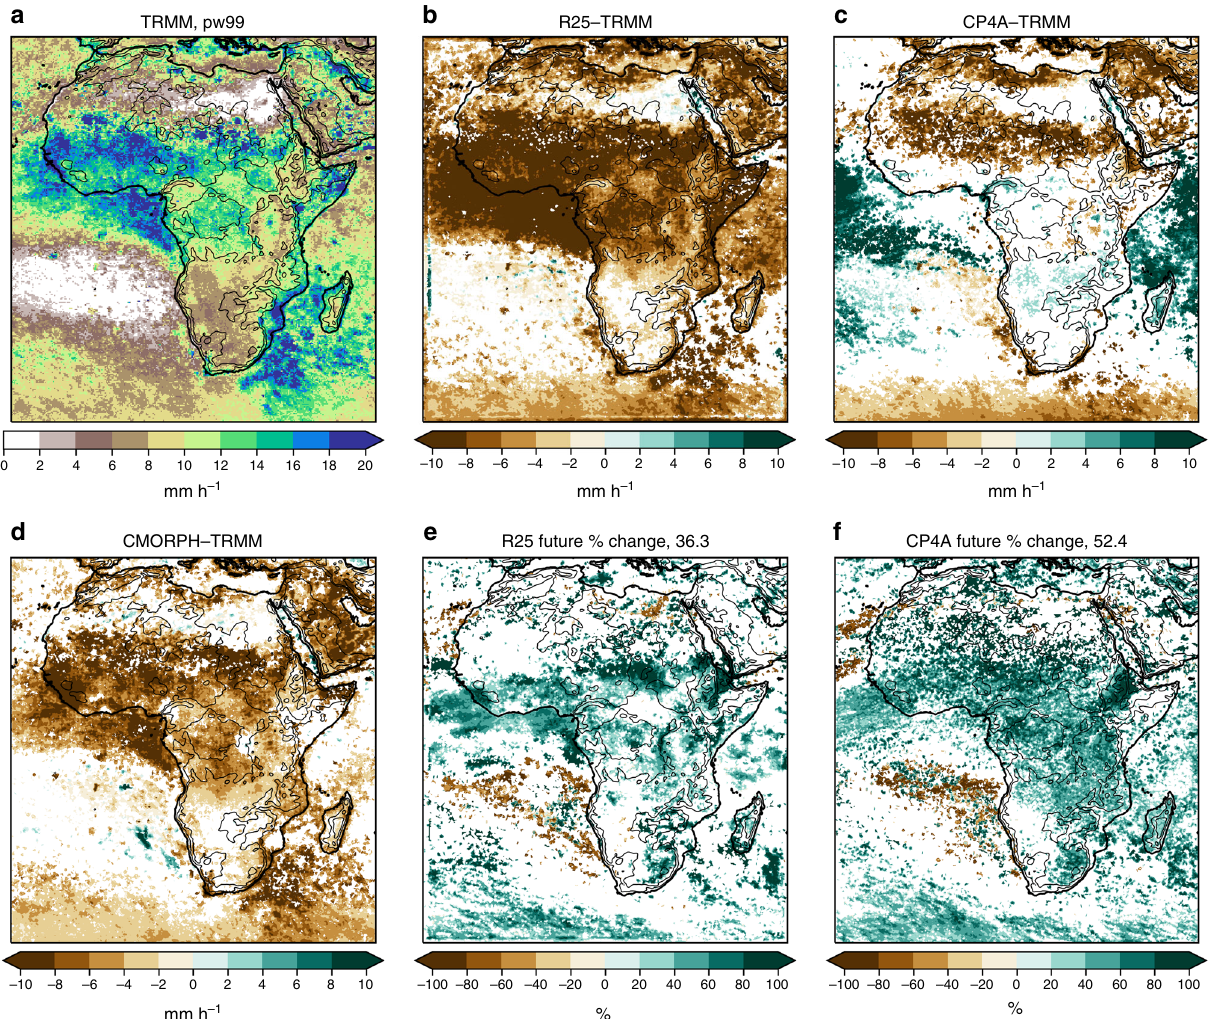
Fig. 5 Wet season extreme precipitation intensity. a TRMM observations, differences with respect to TRMM for b the R25 model, c CP4A model and d CMORPH observations, and percentage differences between 2100 and present day for e the R25 model and f CP4A model. Extreme precipitation intensity is de fi ned as the 99th percentile of wet values (>0.1 mm h − 1 ), for 3-hourly precipitation. The median of future percentage changes across Africa (land points only) is indicated in e , f . Dataset differences and future changes are masked in white, where differences are not signi fi cant at the 5% level compared with year-to-year variability. The wet season is the 3-month period with the highest mean precipitation in TRMM, de fi ned on a grid-point basis. The black lines indicate the 500 -, 1000 -, 2000-, 3000 - and 4000 -m